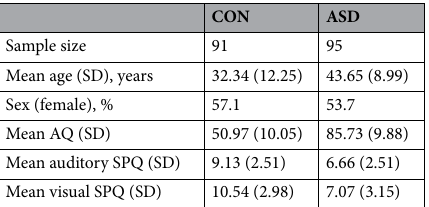
Table 2. Characteristics of study participants. AQ Autism-spectrum quotient, SPQ Sensory Perception quotient, SD standard